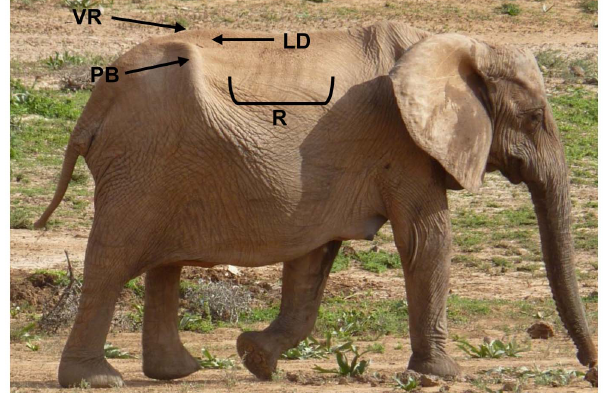
Figure 2. Key areas for visually assessing body condition in female African elephants. R= ribs, PB= pelvic bone, VR= vertebral ridge of backbone, LD= lumbar depression alongside backbone.